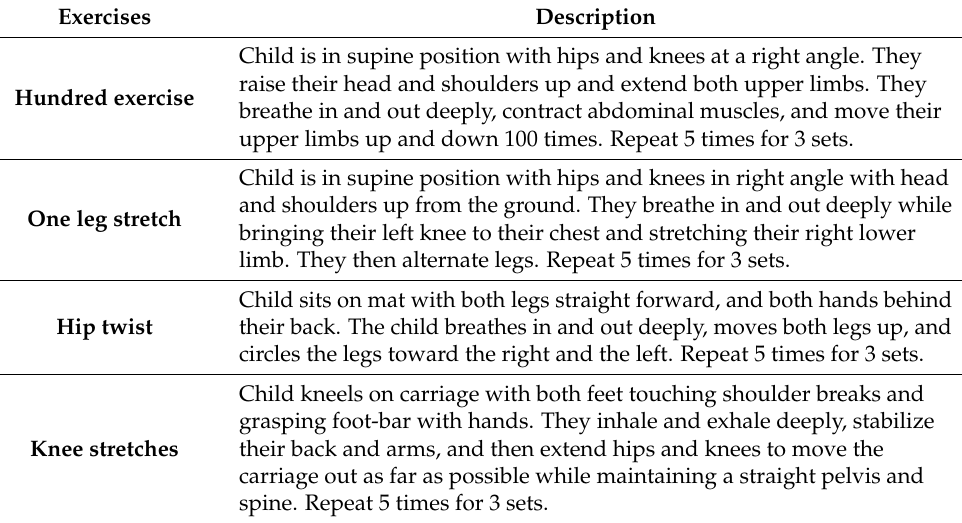
Table 1. Pilates